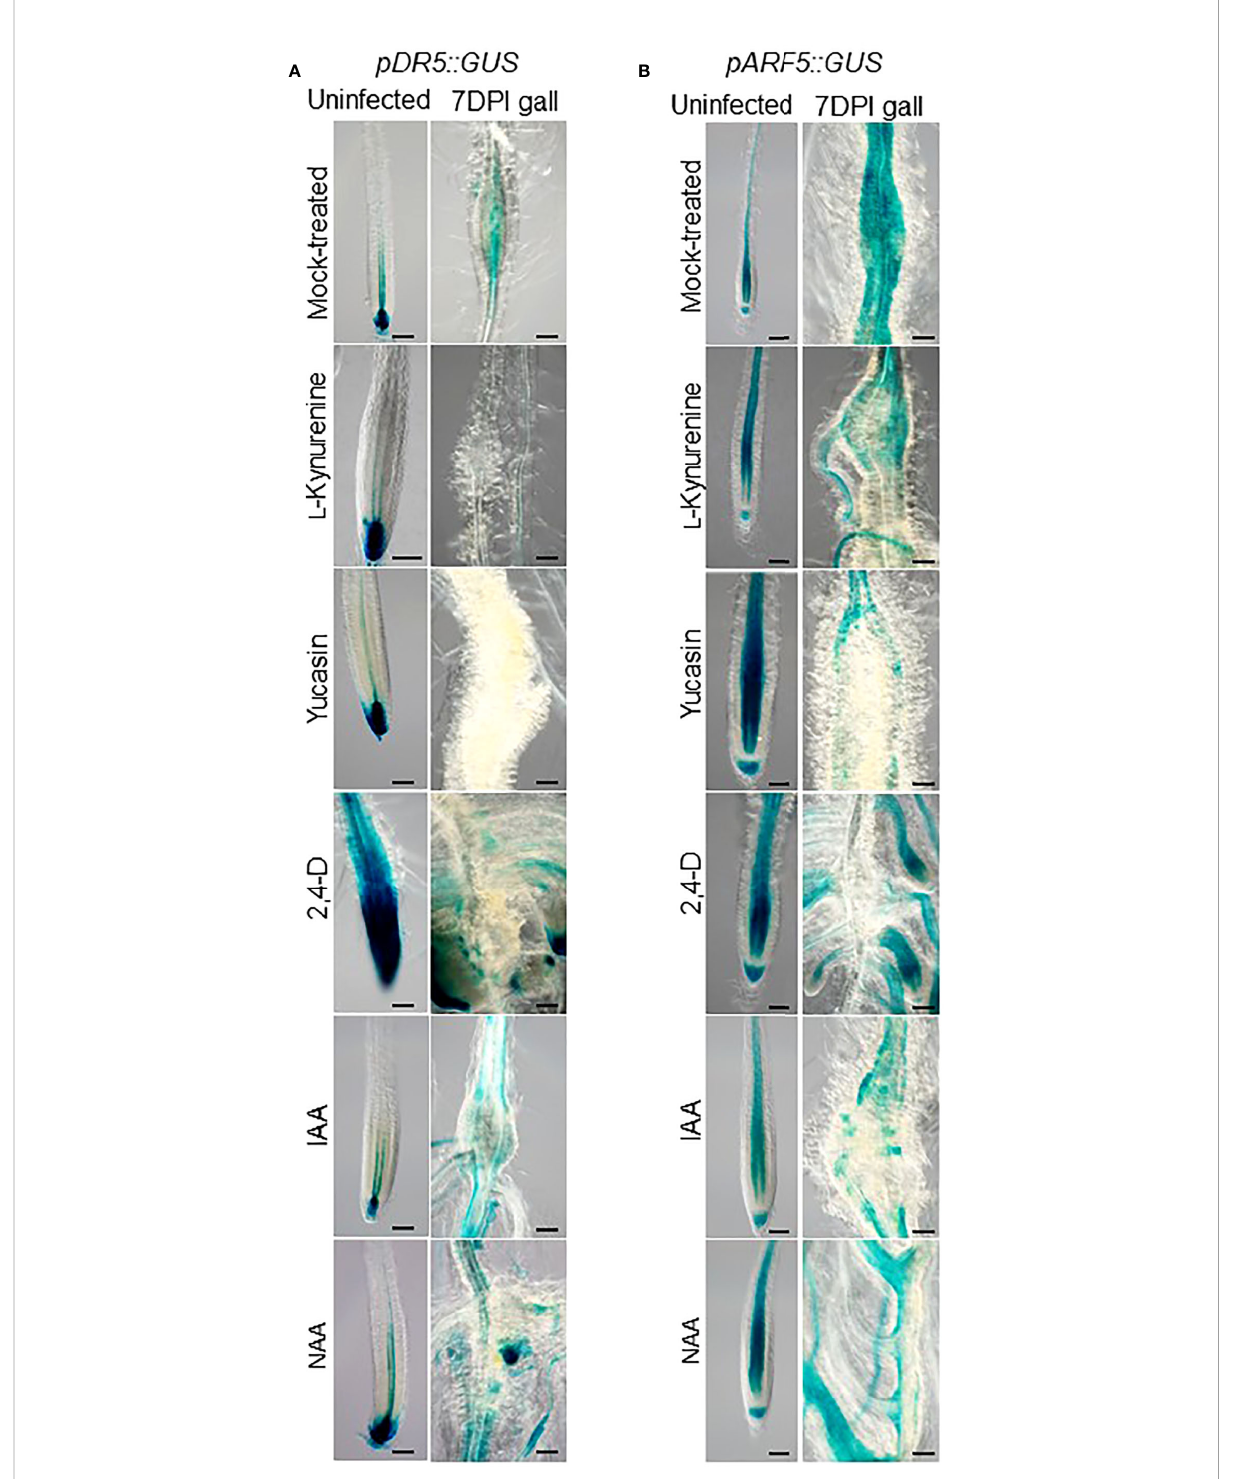
FIGURE 1 Localized auxin responses in galls alter in response to exogenous auxin treatments. Transgenic Arabidopsis seedlings with pDR5::GUS (A) or pARF5::GUS (B) reporter constructs that were mock (DMSO)-treated, treated with auxin synthesis inhibitor (10 μM L -kynurenine, 50 μM yucasin), or synthetic auxin analogues (0.1 μM 2,4-D, IAA or NAA), inoculated with RKN for 7 days or uninfected, then stained for GUS. Bar = 100 μm. At least three independent transgenic lines for each construct were examined with similar